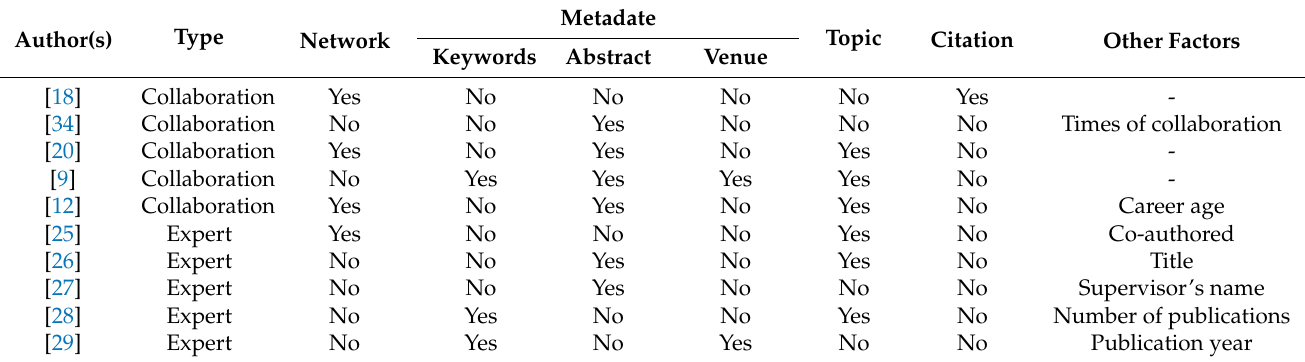
Table 1. Review of the used factors in the